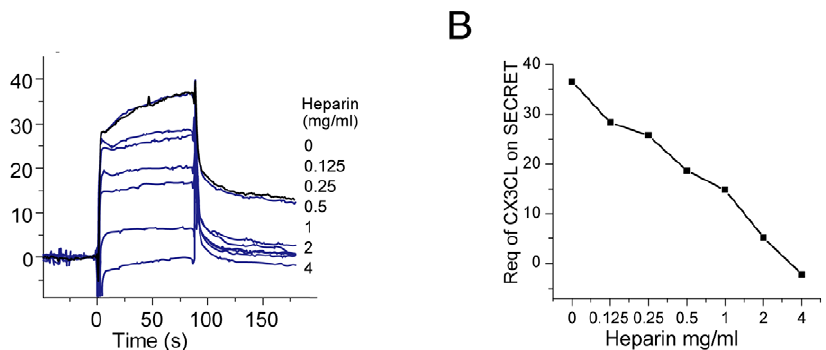
Figure 5. The SPR analysis of SECRET-CX3CL1 interaction in the presence of heparin. (A) Sensorgrams of passing CX3CL1 pre-incubated with an increased concentration of heparin (sodium salt, molecular weight , 15 KD) (0, 0.125, 0.25, 0.5, 1, 2, and 4 mg/ml) through the CM5 chip surface immobilized with the SECRET domain. The binding of CX3CL1 without heparin pre-incubation (0 mg/ml) by the SECRET domain was checked again (response curve in black) after finishing all other measurements to make sure that the decrease of response was not due to the change of chip surface. (B) Heparin interferes with the binding of CX3CL1 by the SECRET domain in a dose-dependent manner.